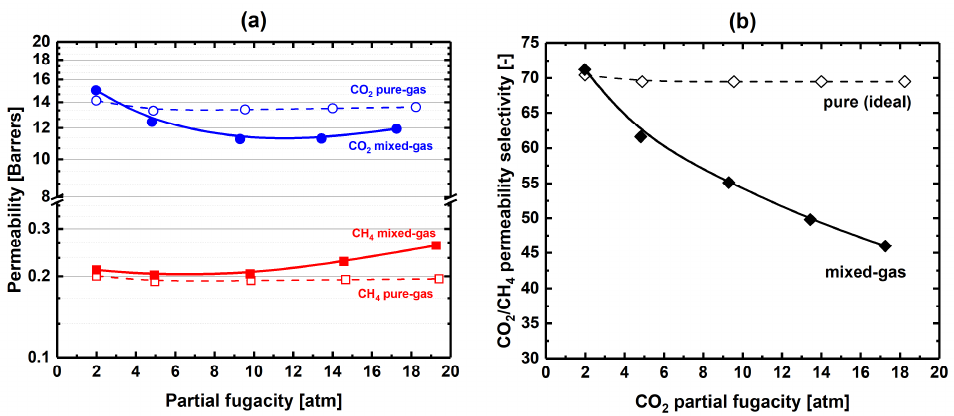
Figure 7. ( a ) CH 4 and CO 2 pure- and mixed-gas permeability data (6FDA-mPDA) vs. partial fugacities; ( b ) CO 2 /CH 4 pure- and mixed-gas permeability selectivity data vs. CO 2 partial fugacities (feed was equimolar). CH 4 and CO 2 permeabilities based on partial pressures were previously reported by our group [29] and corrected with fugacity coefficients. Lines are drawn to guide the eye.